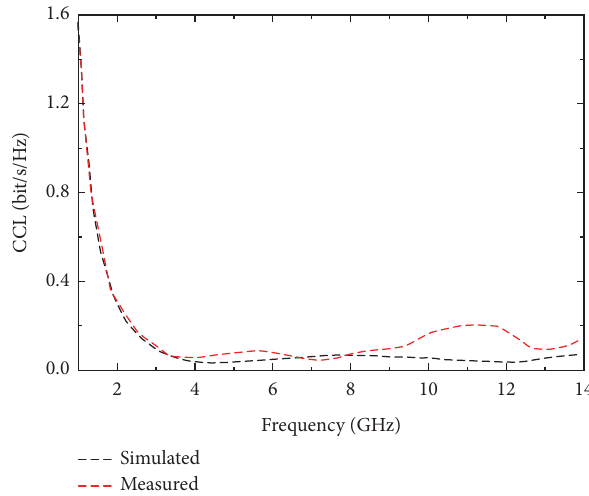
Figure 21: Graph of simulated and measured CCL